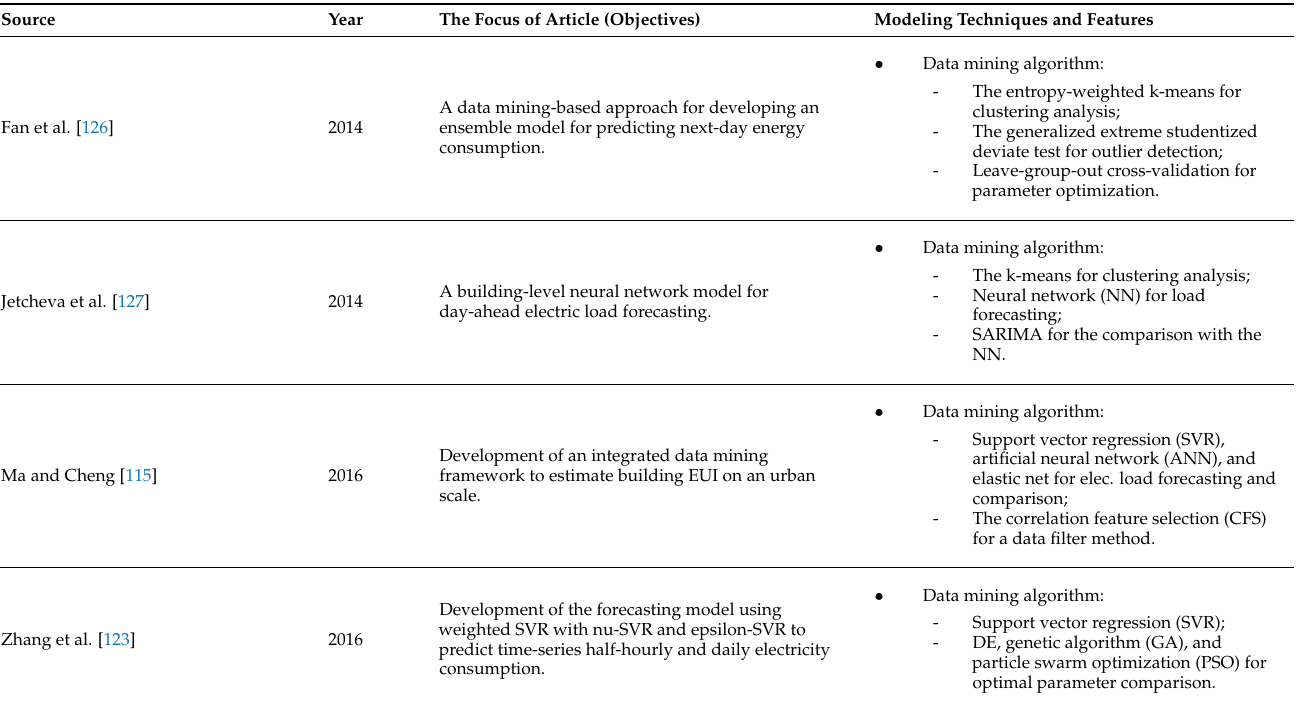
Figure 5. List of the representative “Black-box” modeling techniques, reprinted with permission from Ref. [117]. Table 3. List of the representative reviewed papers regarding “black-box” modeling approaches.